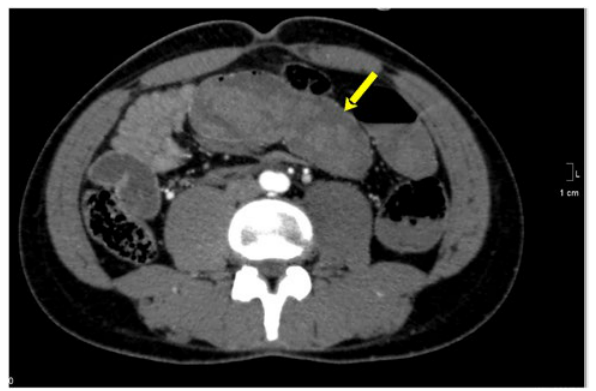
Figure 6b: Axial CT showing gross SBO with a target sign in the right iliac fossa secondary to active Crohn’s